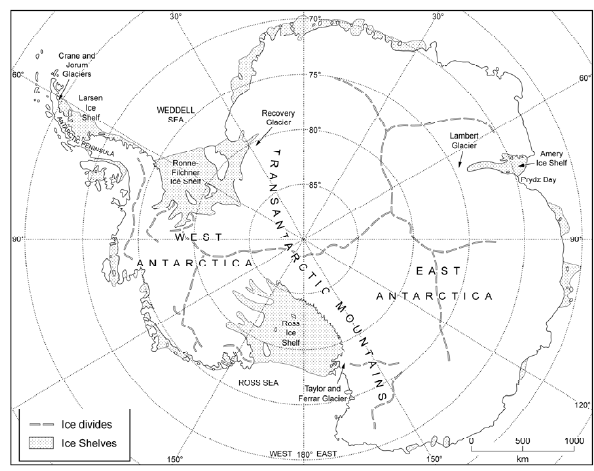
Figure 1. Map of Antarctica showing locations of glaciers studied in this paper. Fig. 1. Map of Antarctica showing locations of glaciers studied in this